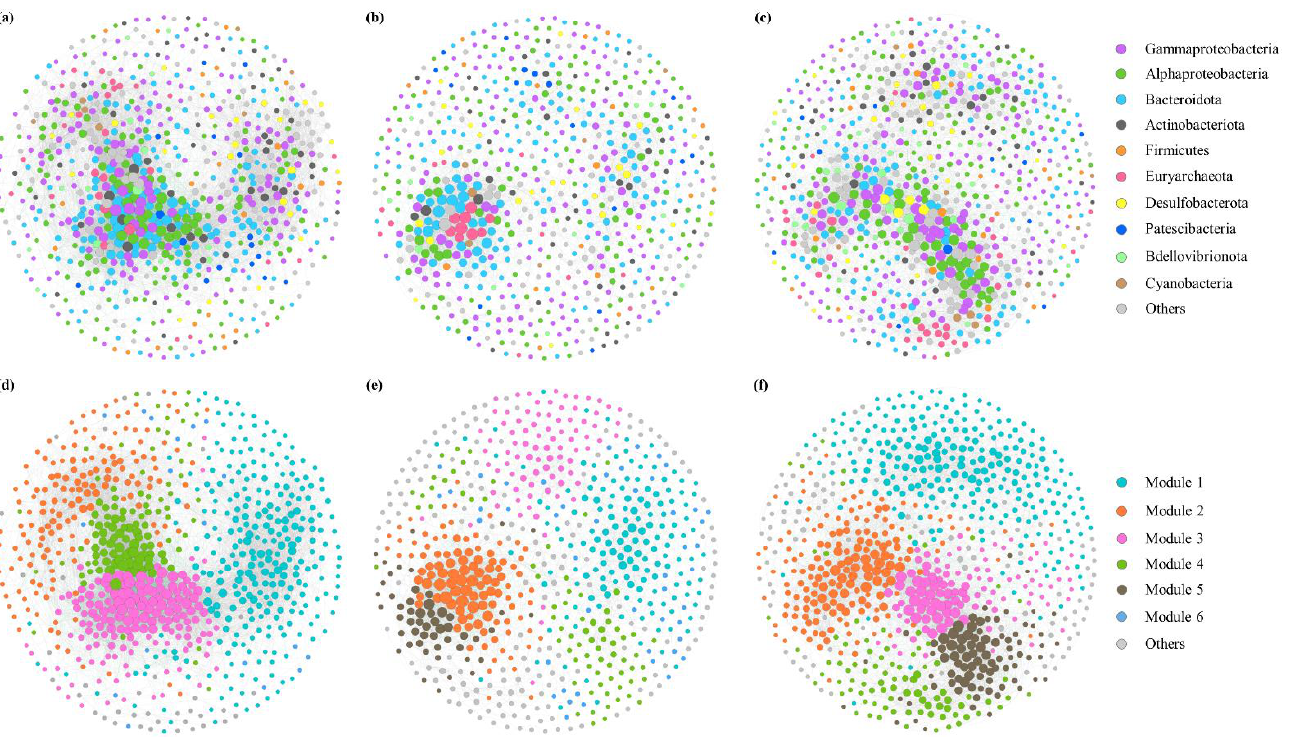
Figure 7. Co-occurrence network colored by taxonomy during the green tide ( a ), the outbreak ( b ) and decline phase ( c ), and colored by modularity during the green tide ( d ), the outbreak ( e ) and decline phase ( f ).